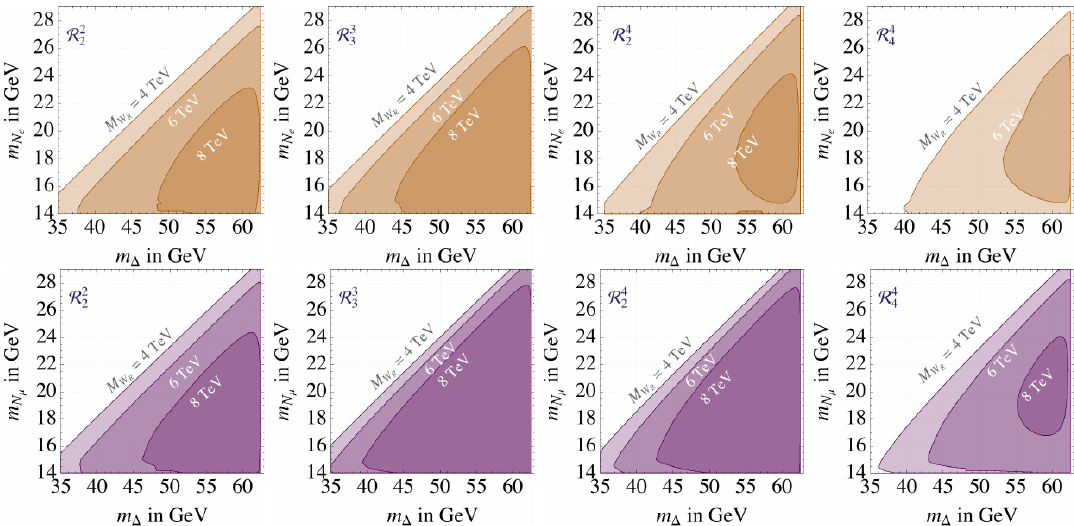
p S + B = 5) for the h ! (cid:1)(cid:1) ! 4 N process in the described (cid:1) L p , while s = 13 TeV ; s (cid:18) = 0 : 1 and the luminosity R